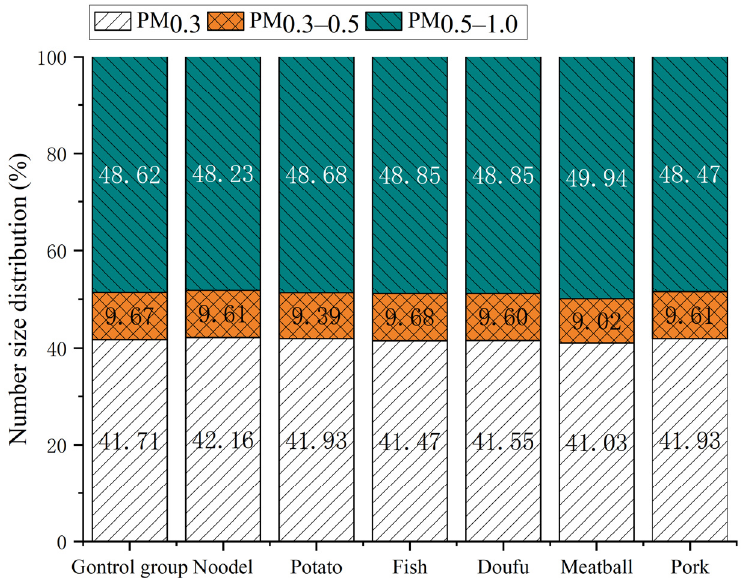
Figure 3. Mean particle size distribution in the food boiling